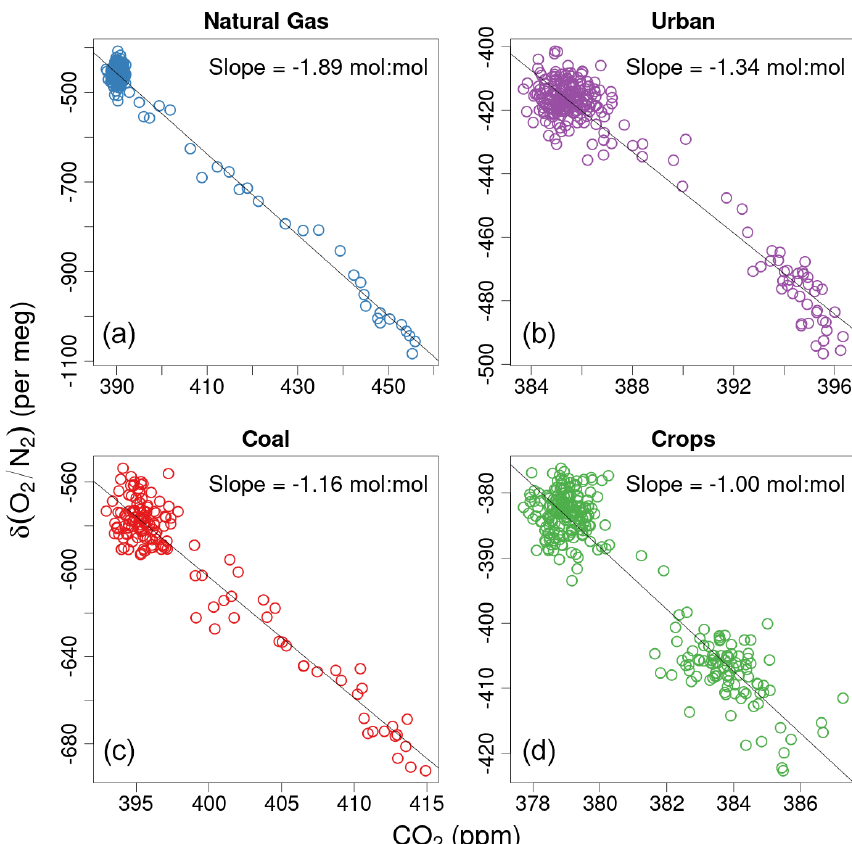
Figure 10. Example O 2 : CO 2 relationships observed with the AO2 instrument from sampling (a) polluted boundary layer air downwind of a natural gas power plant on approach to Anchorage, Alaska, on 12 January 2009 during HIPPO-1 research flight 3, (b) polluted boundary layer air on departure from Broomfield, Colorado, on 20 October 2009 during HIPPO-2 test flight 1, (c) a pollution plume over the San Juan coal power plant near Farmington, New Mexico, on 7 June 2011 during HIPPO-4 test flight 1, and (d) afternoon boundary layer air on approach to Grand Forks, North Dakota, on 23 June 2008 during START-08 research flight 15 (lowest 4km of profile shown in Fig. 9a). Each panel shows the 0.4Hz δ (O 2 / N 2 ) and CO 2 measurements and a least-squares fit line with slope reported in molar